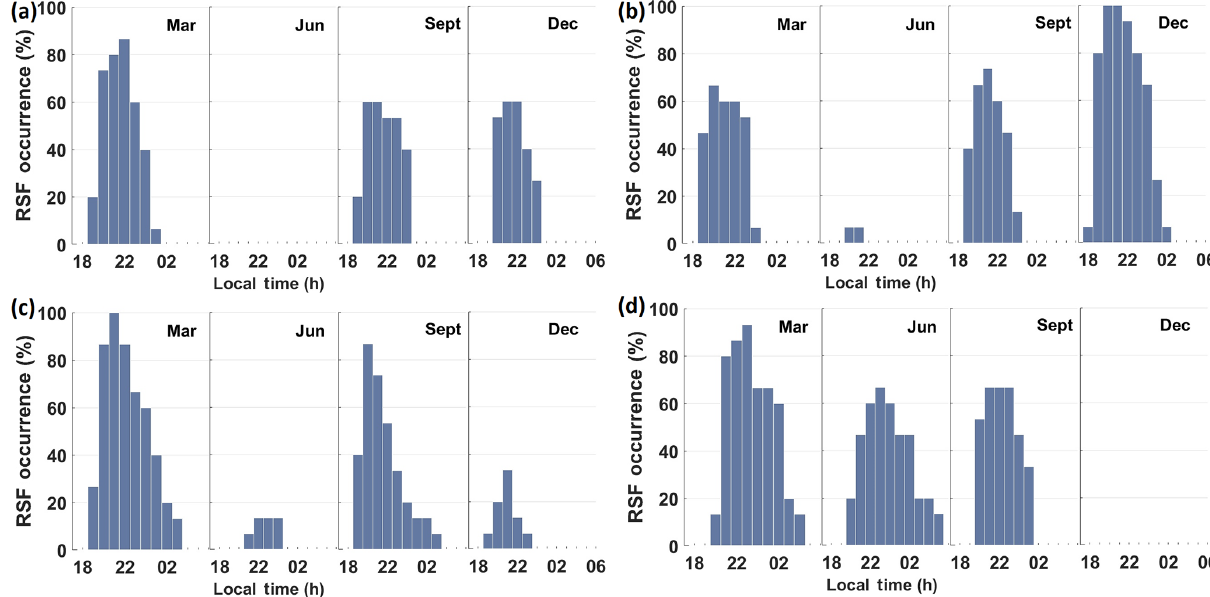
Figure 5. Occurrence rate of RSF during the MSA period at the (a) Jicamarca, (b) Fortaleza, (c) Chumphon and (d) Kwajalein stations.